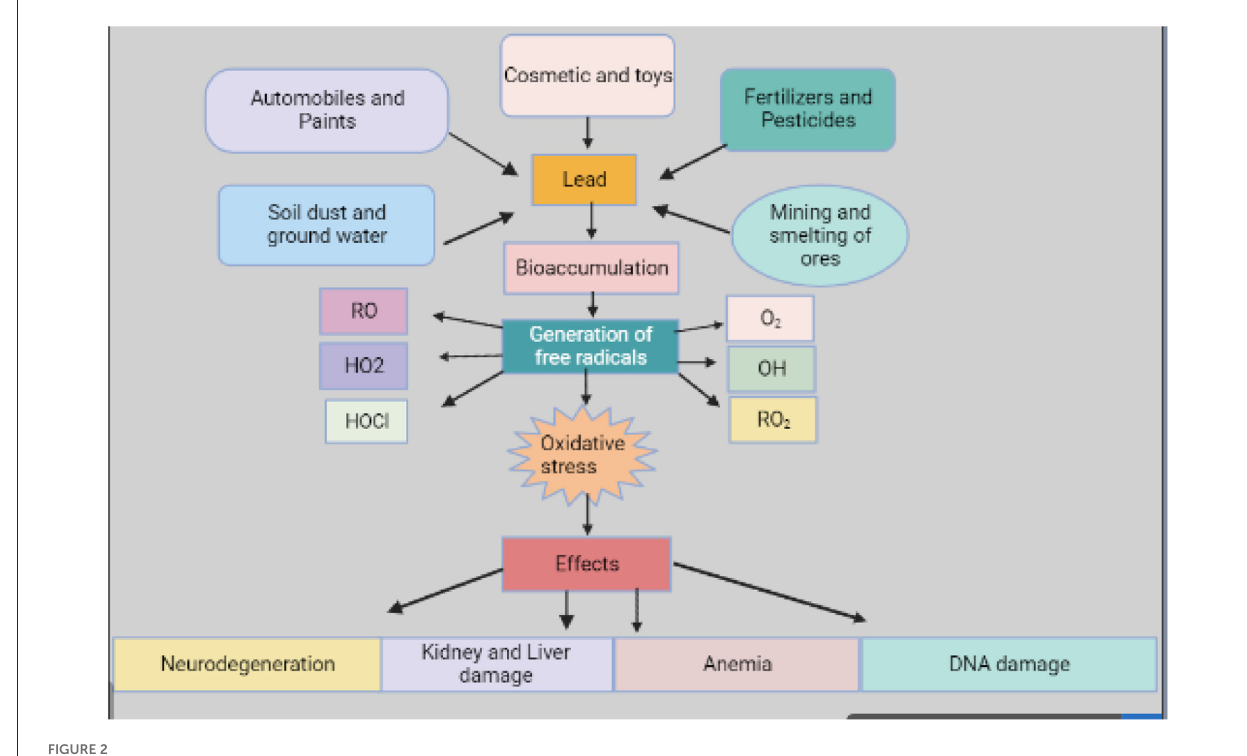
FIGURE2 Source and effects of lead (derived from bio